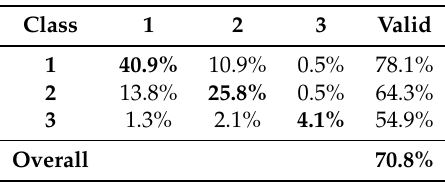
Table 10. Confusion matrix of classified vehicles. Final results for each class on the main diagonal in confusion matrix (highlighted as bold) are